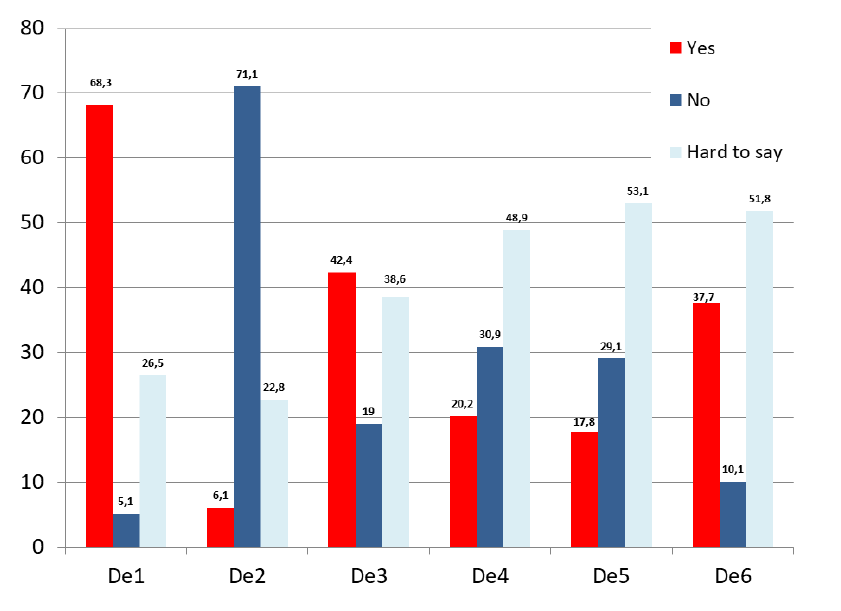
Figure 3. Decisions to install